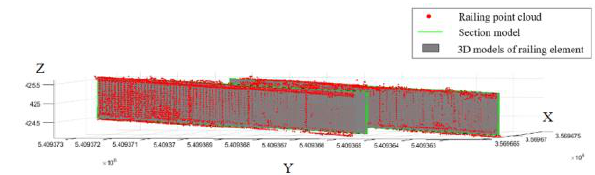
Figure 3. 3D reconstruction of railing element.